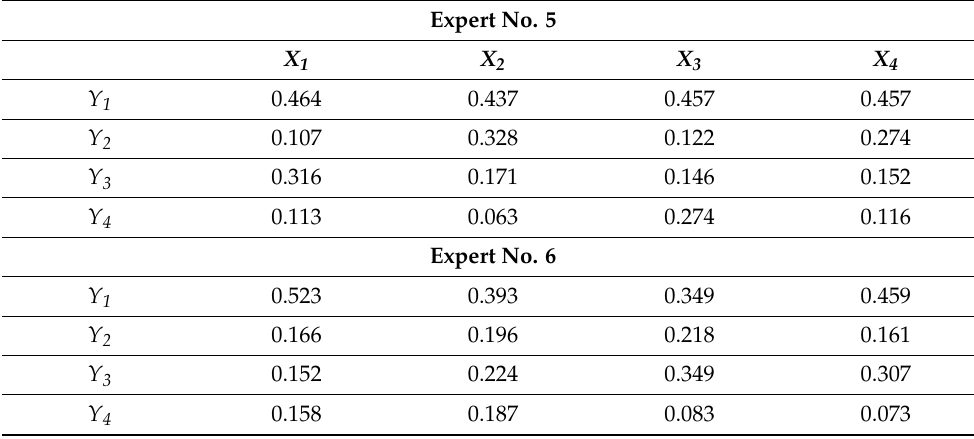
Table 9. CVP for the fourth level of the hierarchy.